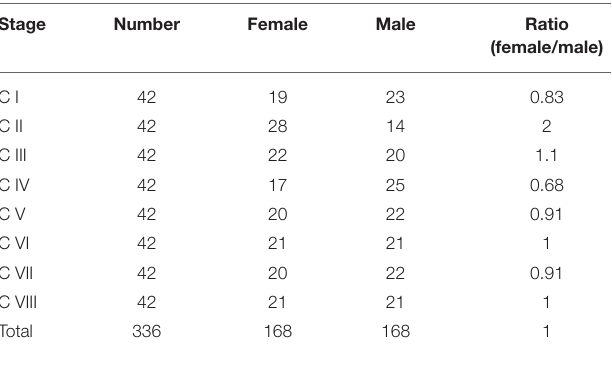
TABLE 2 | Statistics of genetic sex at different development stages of S. paramamosain crablets.